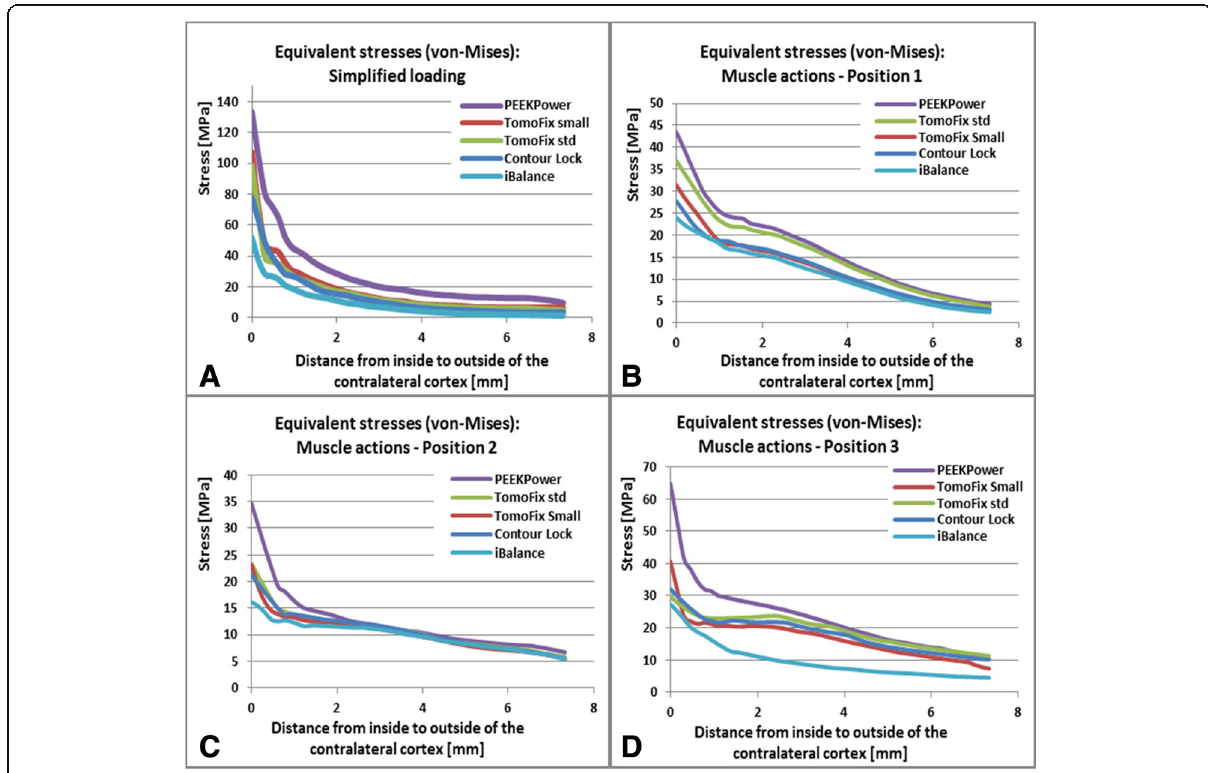
Fig. 10 Equivalent stresses along the path B1B2 of the contralateral cortex (Fig. 2 - b) : a simplified loading of the tibia head. b Lower limb under muscle force loading in the position 1. c Lower limb under muscle force loading in the position 2. d Lower limb under muscle force loading in the position